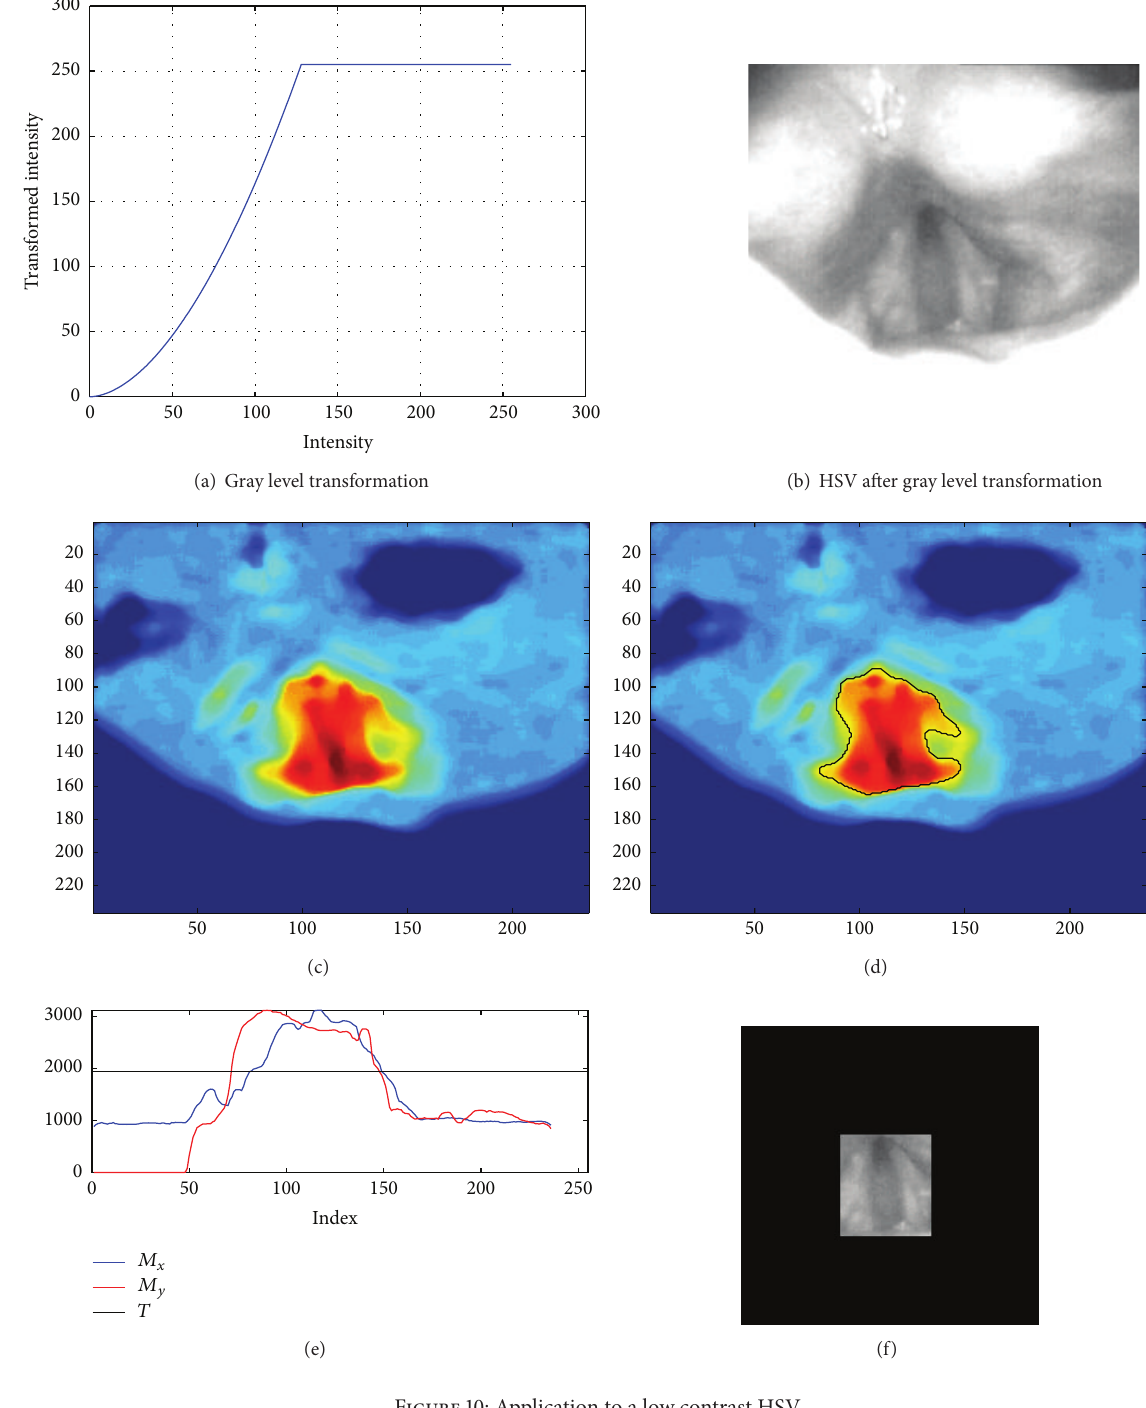
regions at the glottis. The contour of TV-image obtained after thresholding is shown in Figure 8(c). Now, both glottal regions are covered by the contour. The final constructed mask is shown in Figure 8(d). Without using 2D median filter, the masked HSV is erroneous as seen in Figure